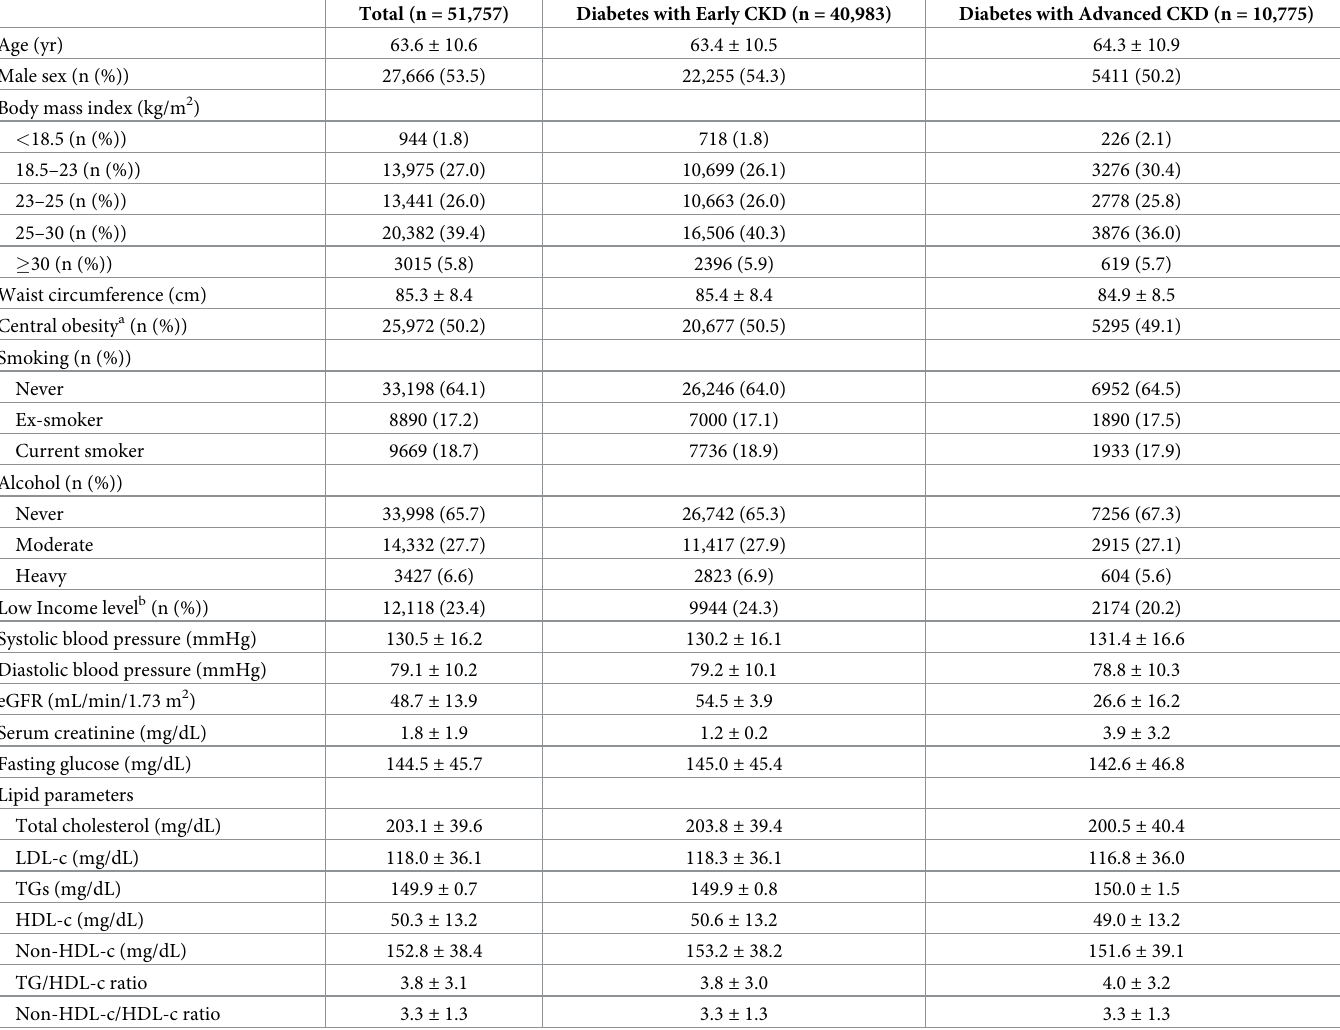
Table 1. Baseline characteristics of study patients stratified by stages of chronic kidney